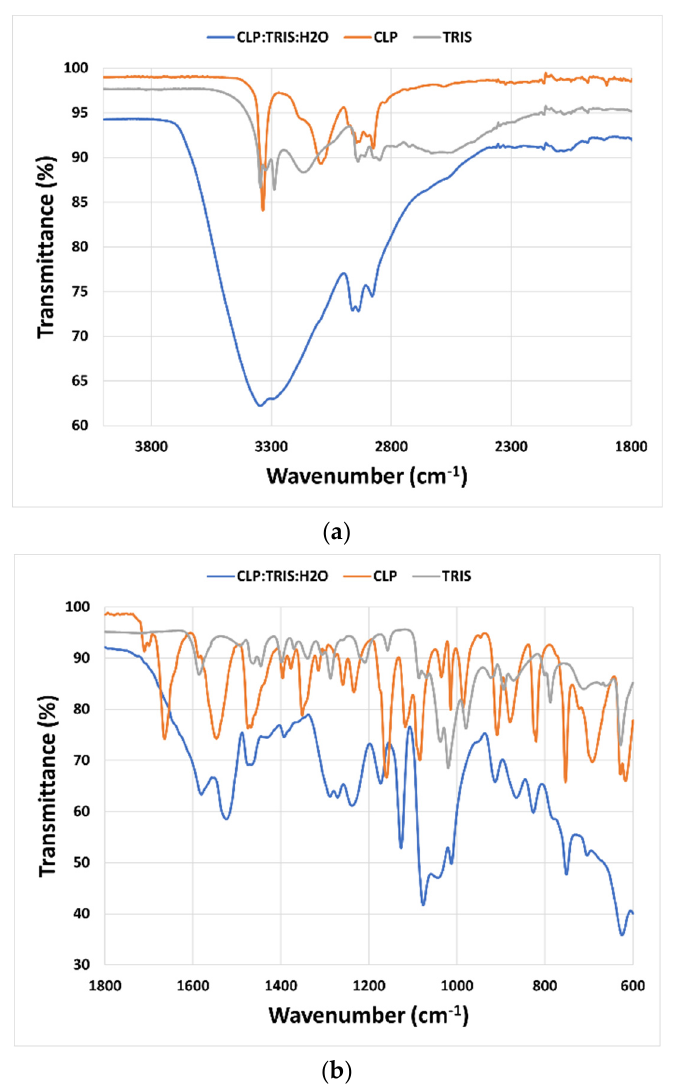
Figure 4. Mid − infrared spectra from the CLP − THELES pure crystalline CLP and pure crystalline TRIS. ( a ) Spectral region between 4000 cm − 1 and 1800 cm − 1 ; ( b ) spectral region between 1800 cm − 1 and 600 cm − 1 .